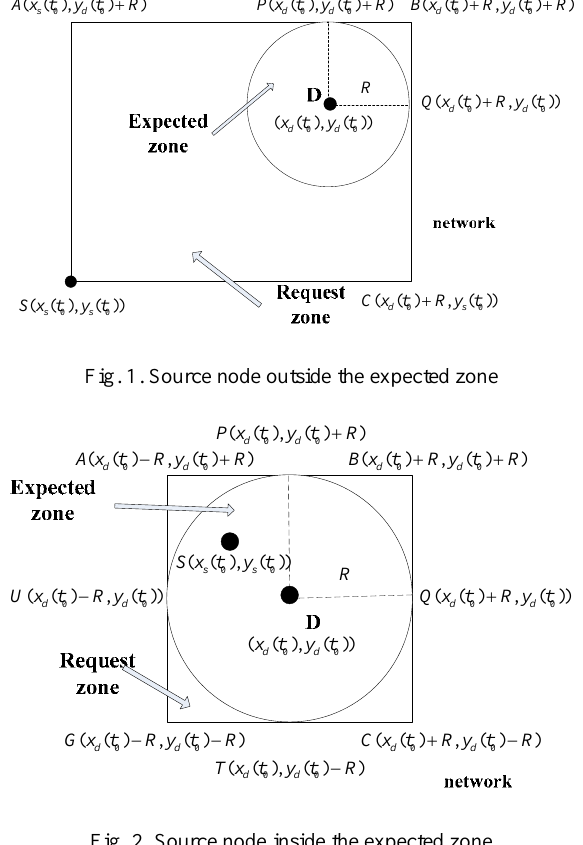
Fig. 2. Source node inside the expected zone Condition 1: the source node is outside the expected zone, which is mathematically given by Eq.